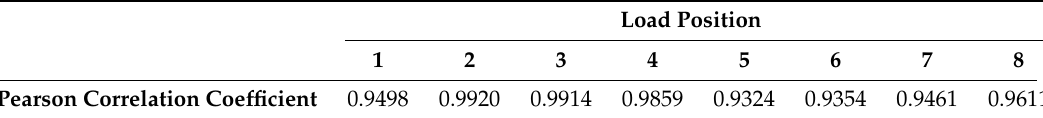
Table A4. Calculated Pearson correlation coefficients.